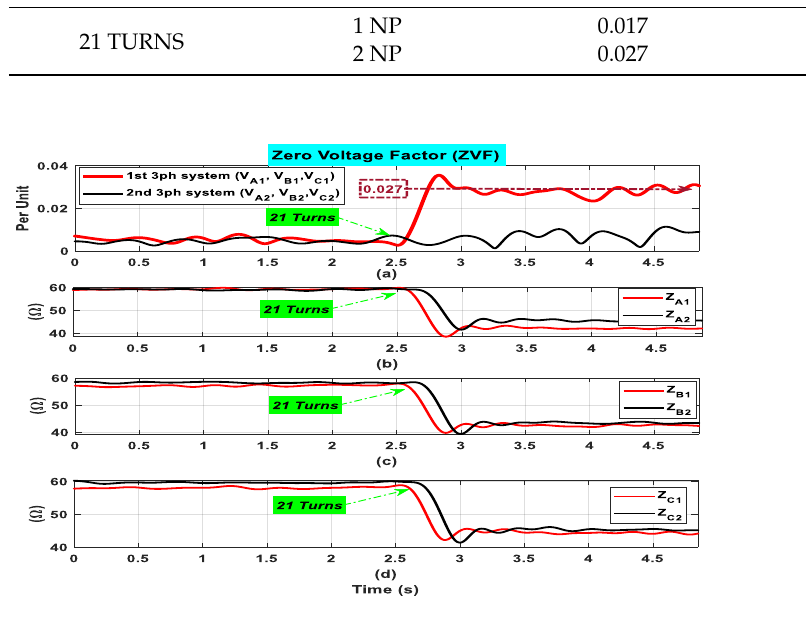
Figure 13. ZVF indicator and estimated impedances, assessed for healthy state and in the presence of 21 shorted turns in phase a 1 . ( a ) ZVF (V A1,B1,C1 and V A2,B2,C2 ); ( b ) Z A1 ; ( c ) Z B1 ; ( d ) Z C1 .